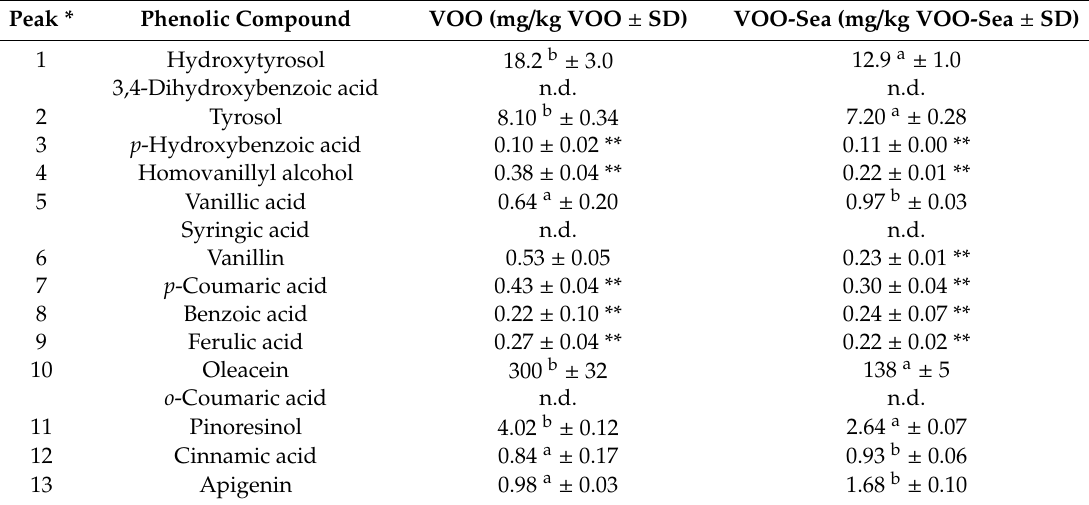
Table 1. Concentrations of phenolic compounds (mean value ± SD; n = 3) in VOO (virgin olive oil) and VOO-Sea (virgin seawater-stored olive oil) determined by high-performance liquid chromatography-diode array detector (HPLC-DAD) analysis.